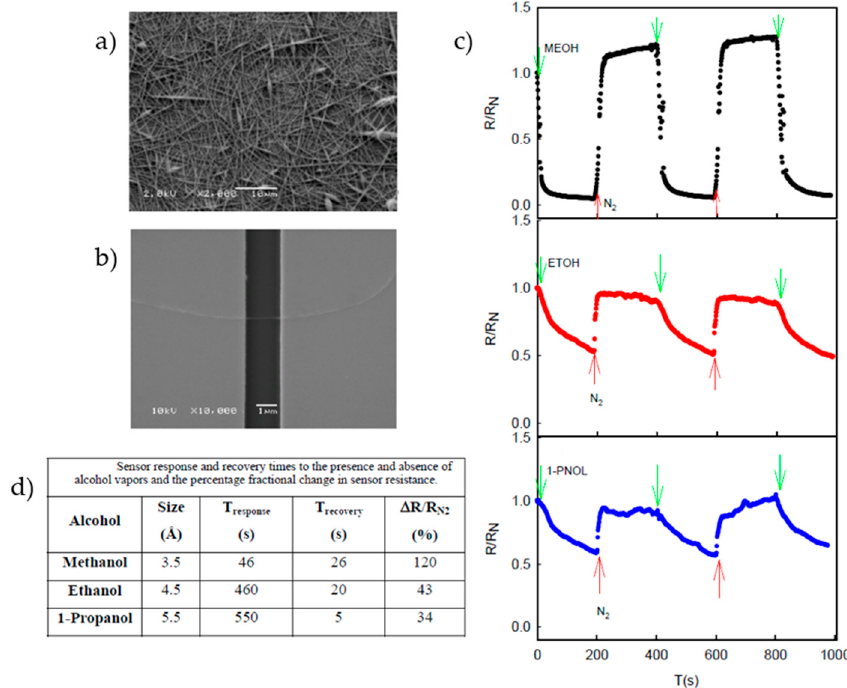
Figure 10. SEM images of 3 wt % PLA/PANI-CSA ( a ) and single nanofiber sensing device ( b ). Sensor characterization of alcohol vapors ( c ). Response and recovery times for each alcohol ( d ). Adapted with permission from ref [107].